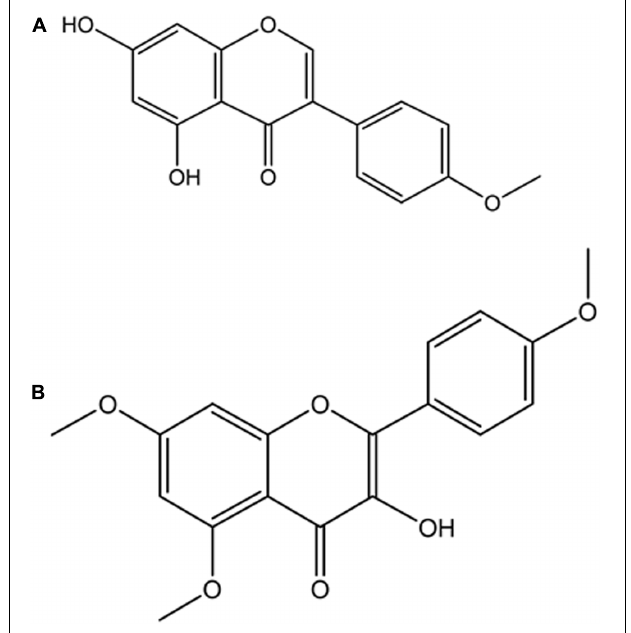
FIGURE 9 | Isolated compounds from DCM fraction of C. volubile methanolic extract. (A) 4’-methoxj’-5,7-dihydroxy isonnvone (Biochanin); (B) 5,7,4’-trimethoxykaempferol.